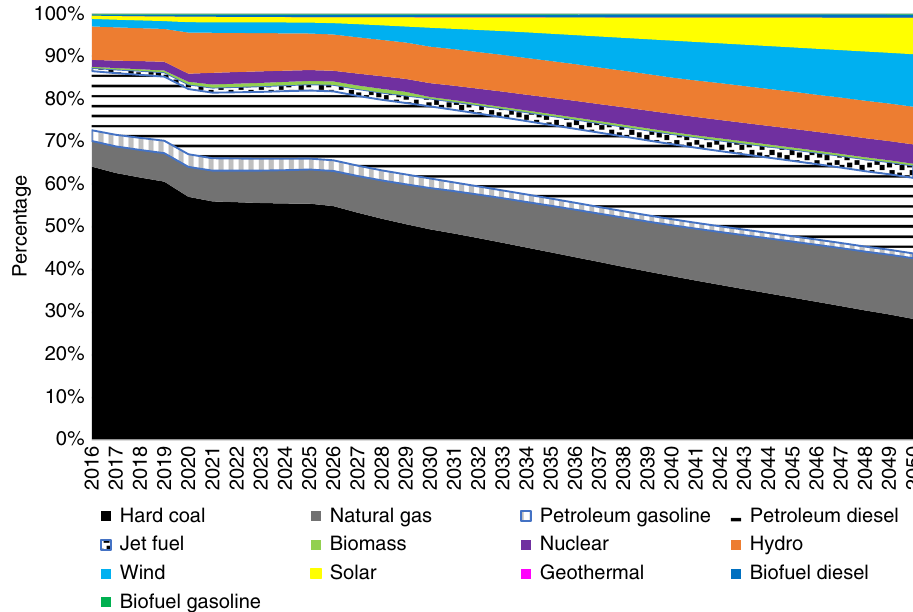
Fig. 6 Primary energy use by fuel type in the policy package scenario. Bright colors show the share of primary energy use in China from non-fossil fuels, including biomass (light green), nuclear (dark purple), hydro (orange), wind (blue), solar (yellow), geothermal (purple), biofuel diesel (dark blue), and biofuel gasoline (dark green). The total share of non-fossil fuels in China ’ s primary energy consumption gradually increases and will reach to 19.86% by 2030. China will, therefore, nearly meet its commitment of 20% of primary energy consumption from non-fossil fuels by